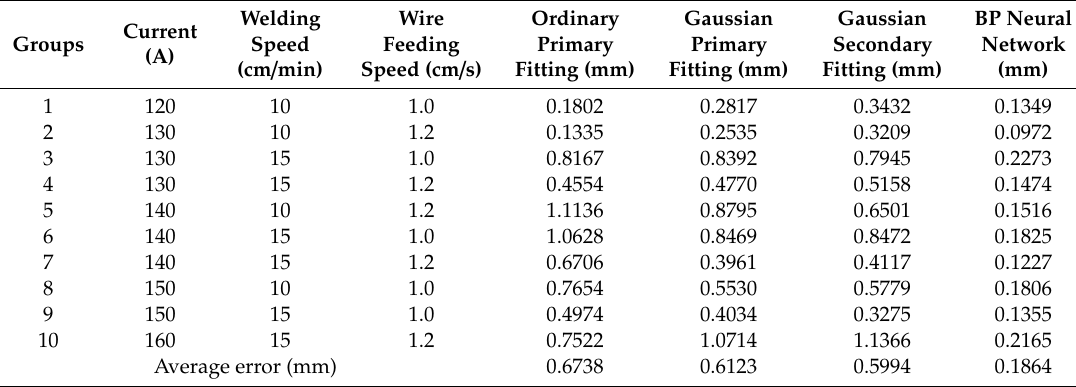
Table 5. Prediction errors of four methods under di ff erent welding process parameters.